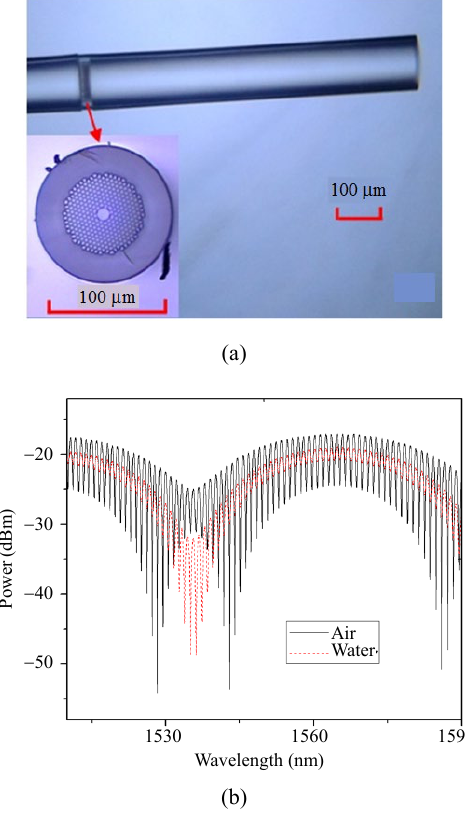
Fig. 3 Experimental results of sensor fabrication: (a) microscopic images of the fabricated FPI and the cross-section of HC19-1550 (inset) and (b) interference spectra of the fabricated FPI in air and water.